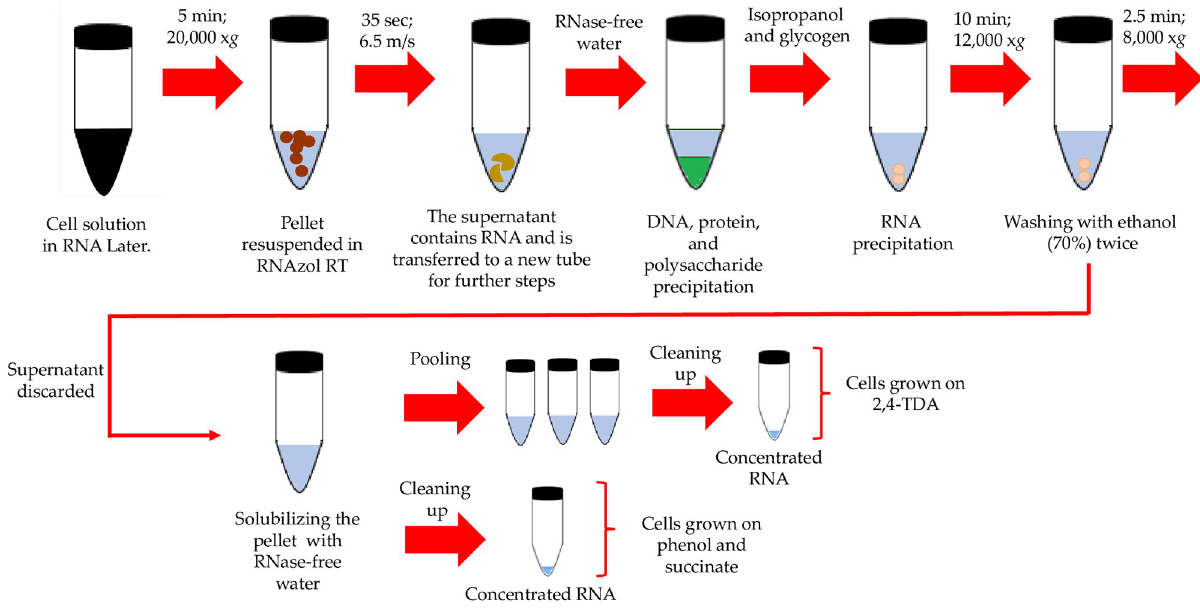
Fig 1. Optimized RNA extraction method from Pseudomonas capeferrum